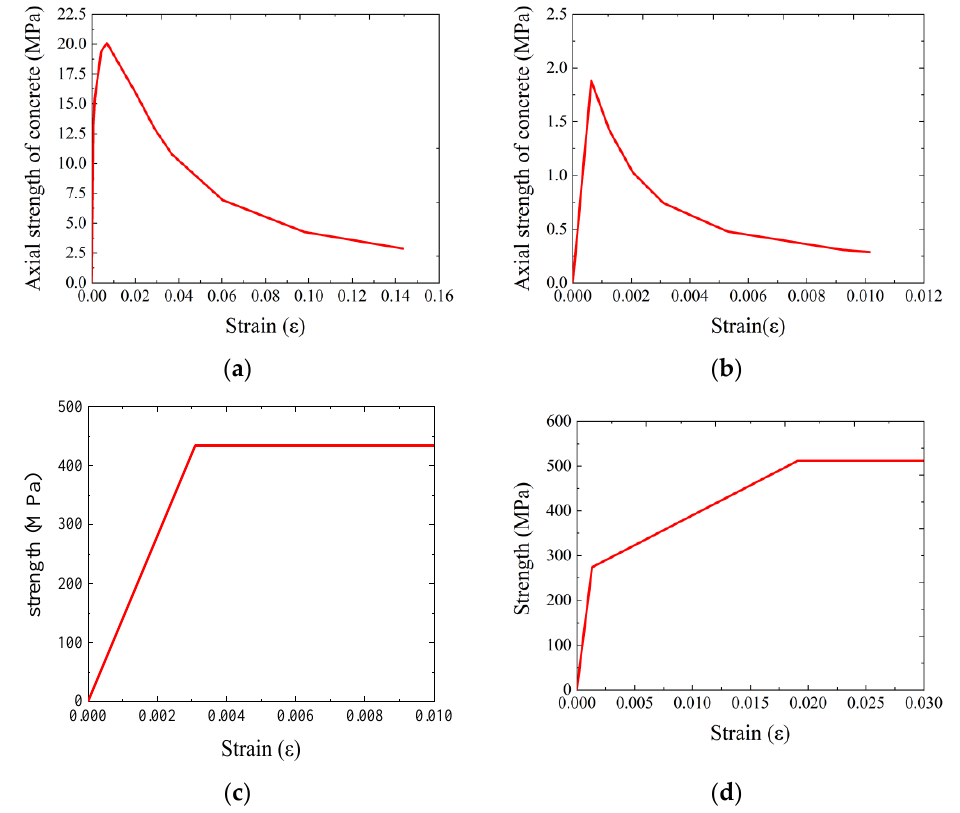
Figure 16. Constitutive Relations. ( a ) Concrete compression behavior. ( b ) Concrete tensile behavior. ( c ) Reinforcement behavior. ( d ) Steel plate behavior.